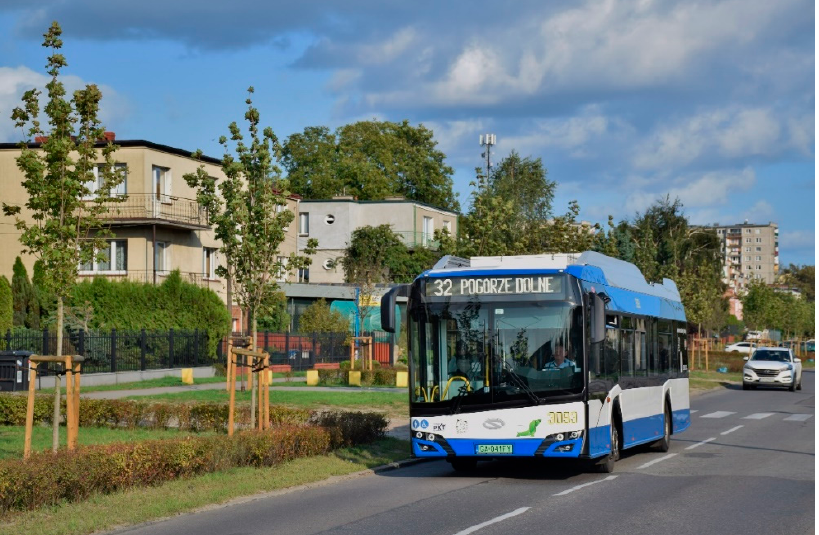
Figure 3. A trolleybus running on line 32 using battery power in Gdynia (photo taken by M. Połom).